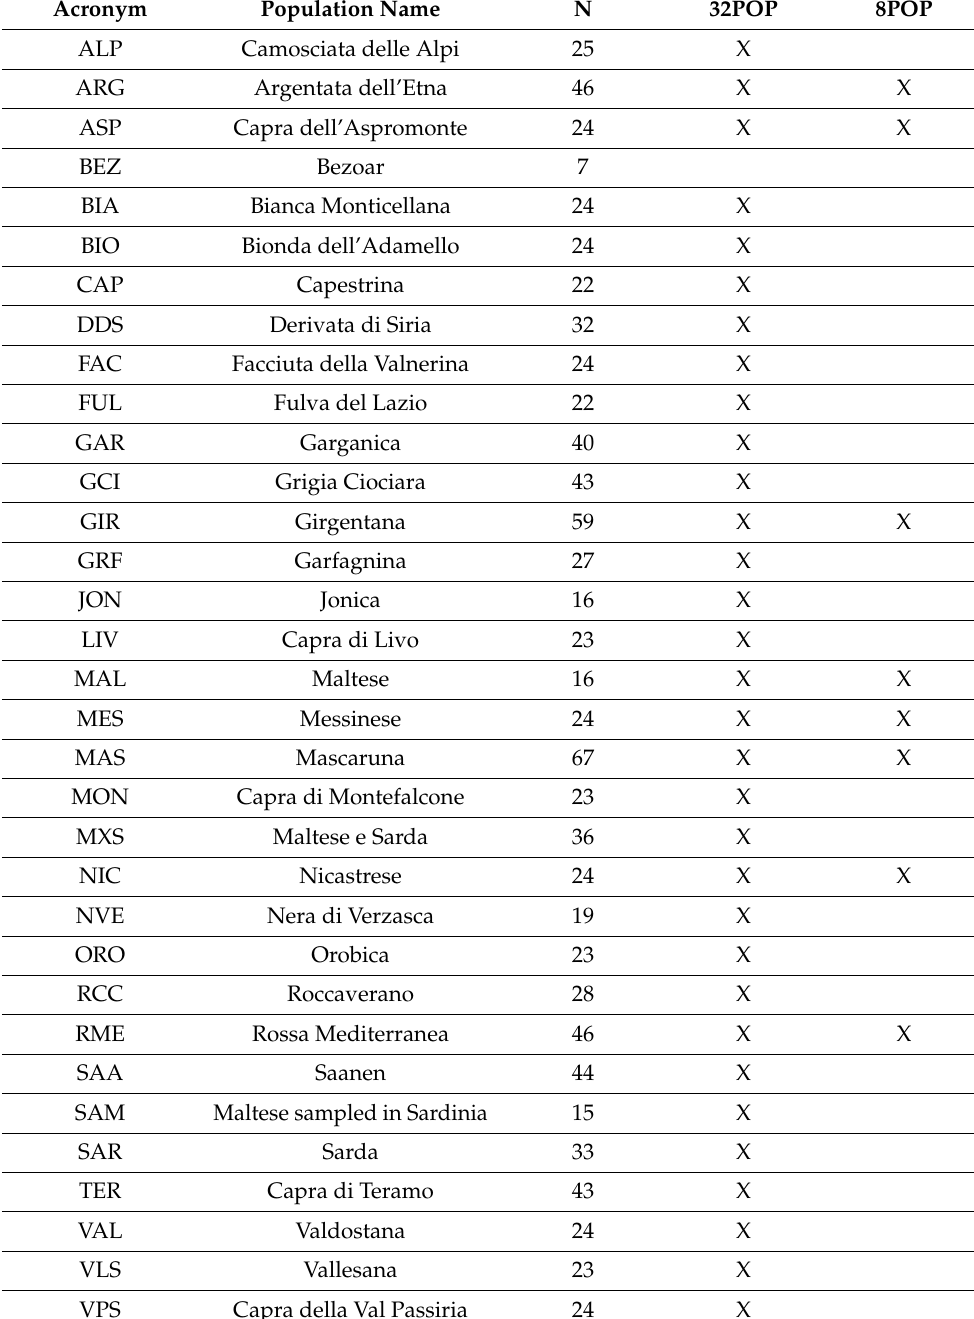
Table 1. Acronym, population name, number of individuals after quality control (N) used in the